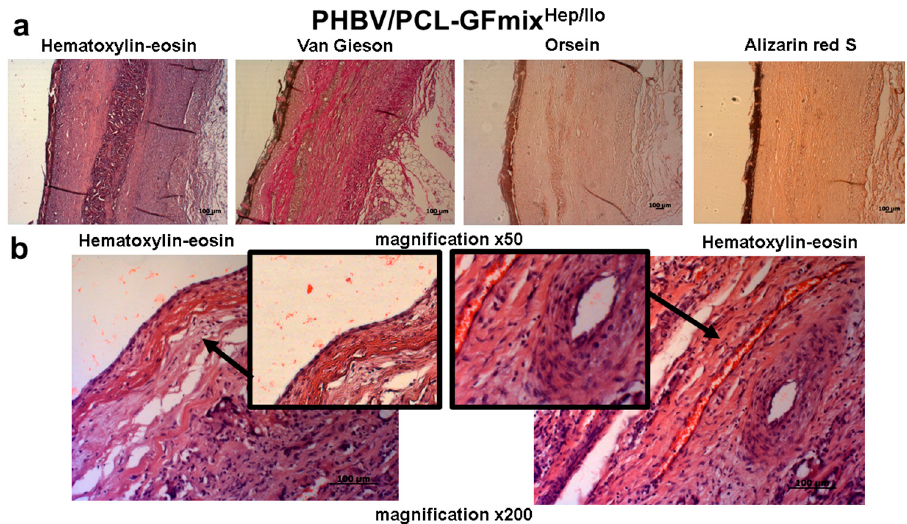
Figure 5. Representative images of PHBV/PCL-GFmix Hep/Ilo grafts explanted 6 months following surgery. ( a ) Magnification ×50. ( b ) Magnification ×200. Scale bar = 100 μ m.